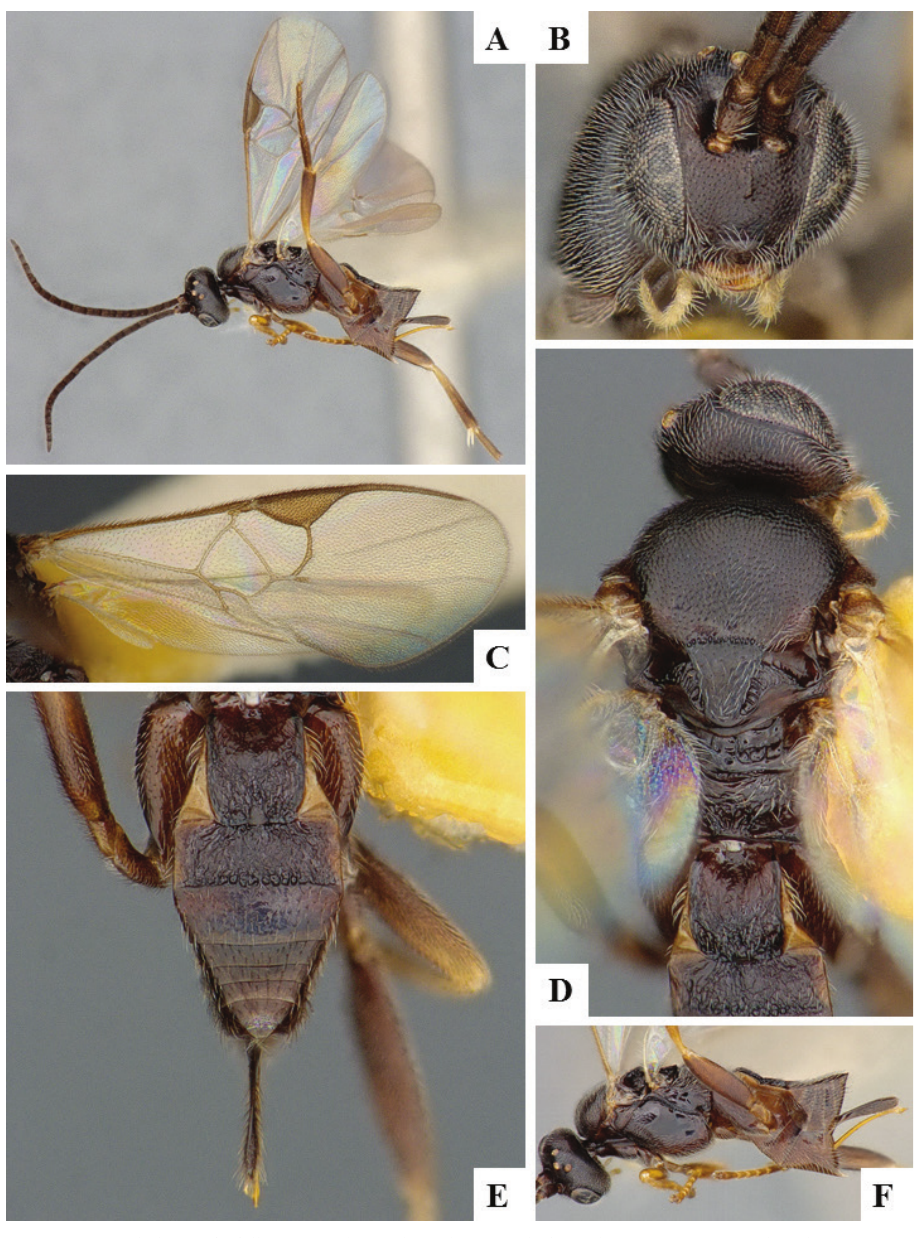
Figure 31. Pholetesor bedelliae. A Habitus, lateral B Head, frontal C Wings D Head and mesosoma, dorsal E Metasoma, dorsal F Mesosoma and metasoma,